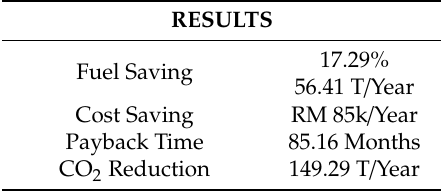
Table 3. Impacts of Implementation of Waste Heat Recovery on B01.